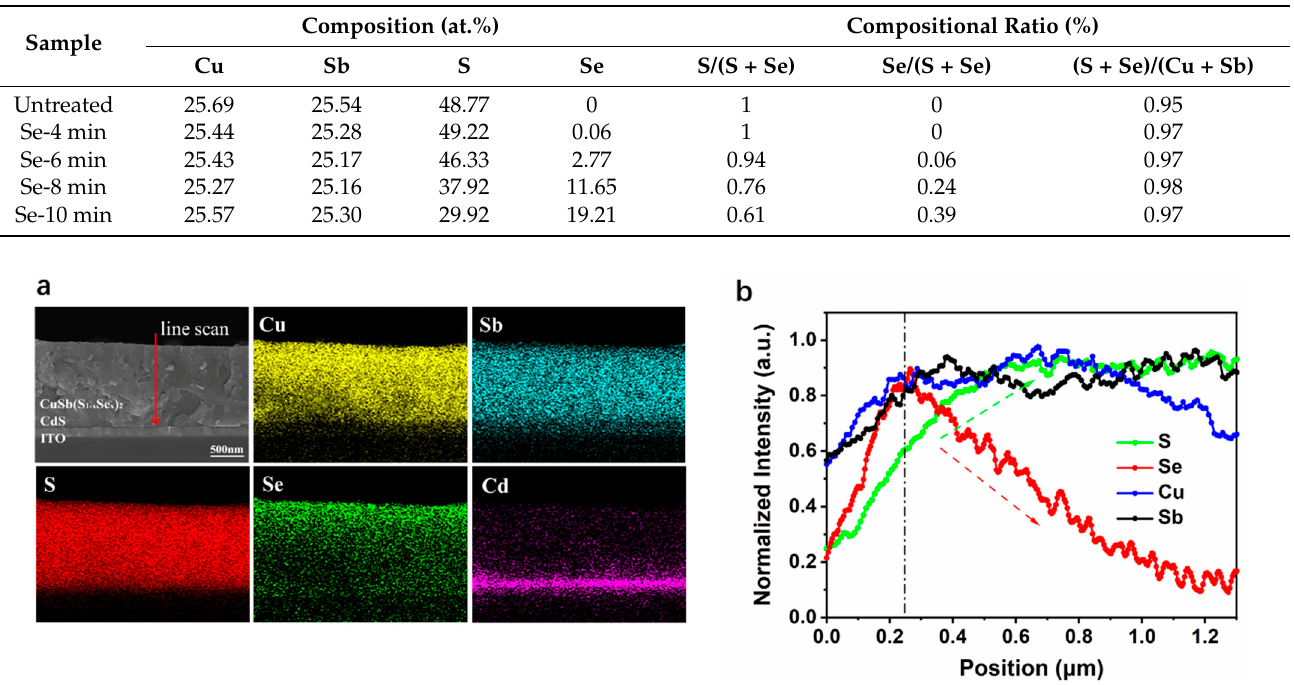
Table 3. Global elemental analysis of Cu, Sb, S, and Se elements in CuSbS 2 (Se) samples selenized for different durations.